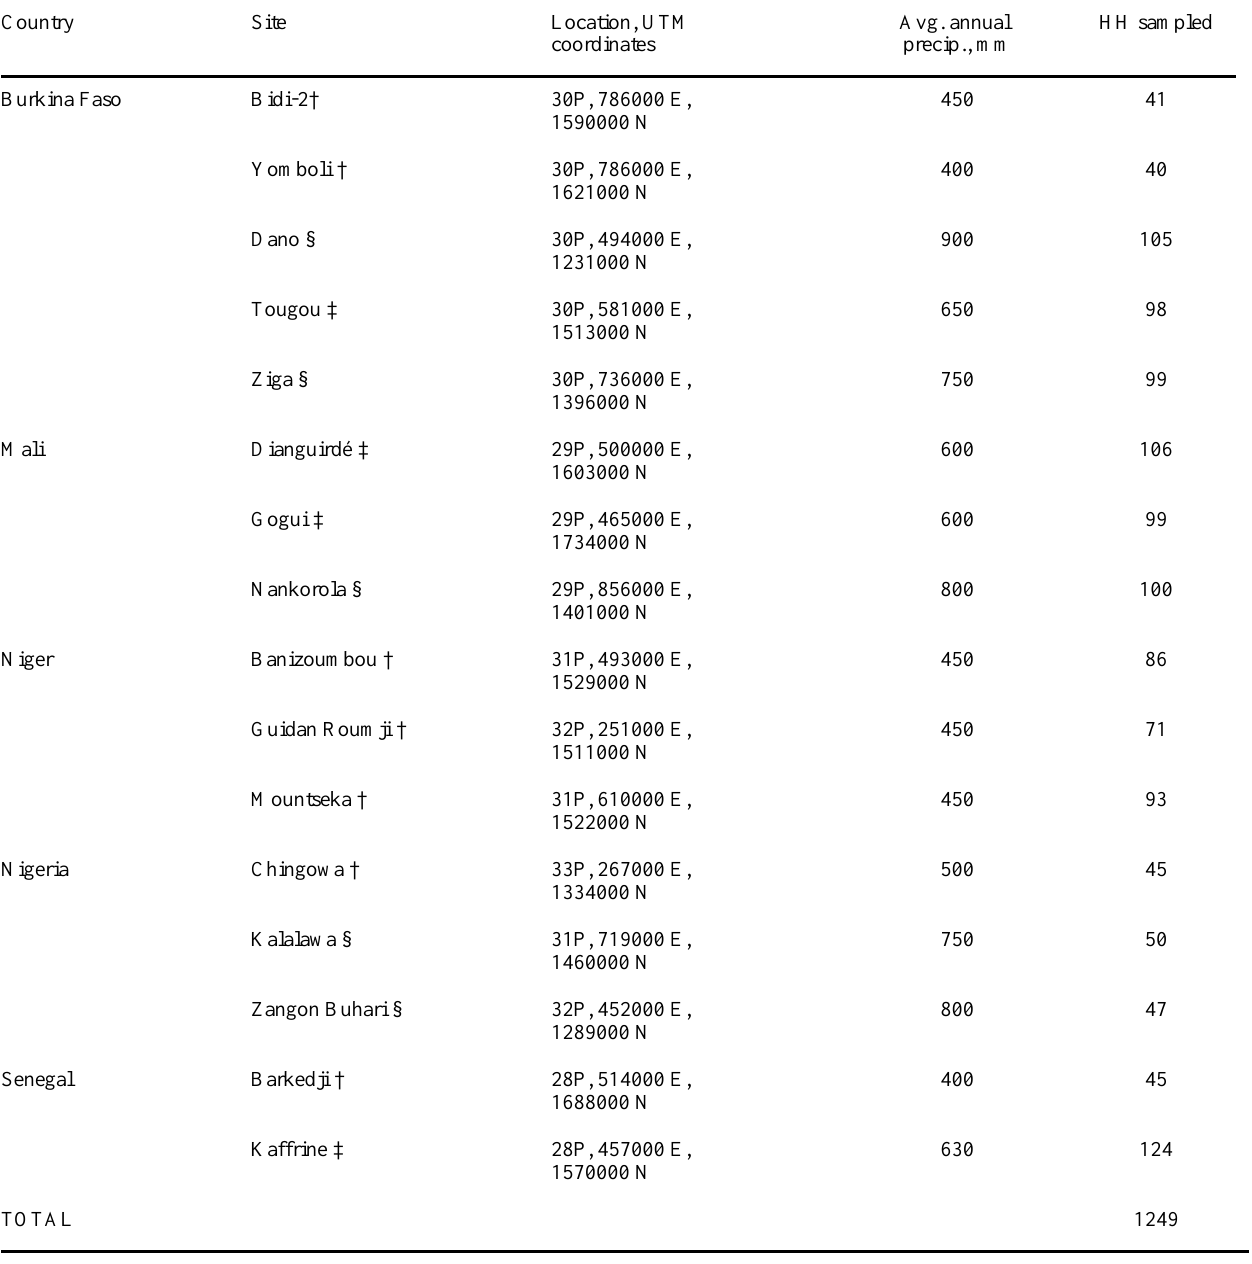
Table 1. Field sites in West Africa with location, annual precipitation, and number of households (HH)